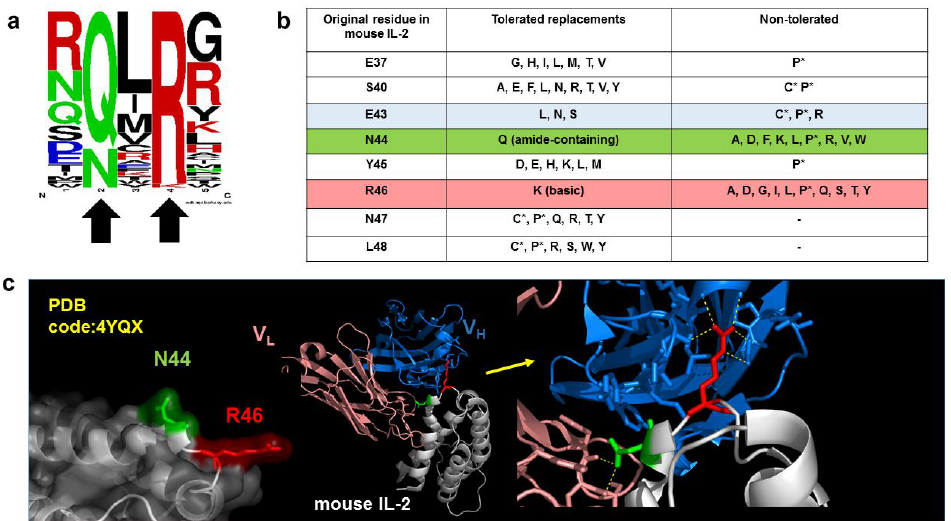
Figure 3. Identification of an epitope in mouse Interleukin-2 by different methods ( a ) The weblogo represents the common peptide motif identified in 45 out of 47 peptide ligands selected from a random phage-displayed decapeptide library with the antibody JES6-1A12 (anti-mouse Interleukin-2). The recurrent motif (Q/N)X(R/K) is distinguished by the presence of an amide-containing residue (Q/N, represented in green) and a basic amino acid (R, occasionally replaced by K, red), which are indicated with arrows [11]. The residue between them, as well as the flanking amino acids (aa), are highly variable. Letter size is proportional to the frequency of a given residue among selected peptides. ( b ) Mutagenesis scanning of phage-displayed mouse IL-2 with the same anti- body revealed the importance of N44 and R46, which could only be replaced by the other am- ide-containing and basic amino acid, respectively [11]. E43 is a minor contributor, as shown by the existence of tolerated and nontolerated mutations at this position. The other residues could be substituted by different aa with diverse properties without affecting antibody recognition. In some cases, replacements by Cys and Pro were not tolerated, probably due to their effects on global protein structure. ( c ) Crystal structure of the antigenic region that contains N44 and R46 (left), and its interface with JES6-1A12 variable domains (center) [77]. The zoom-in view (right) shows the interactions of the two already identified critical aa (N44 and R46) with light and heavy chain var- iable regions. Dotted yellow lines indicate polar contacts established by them.